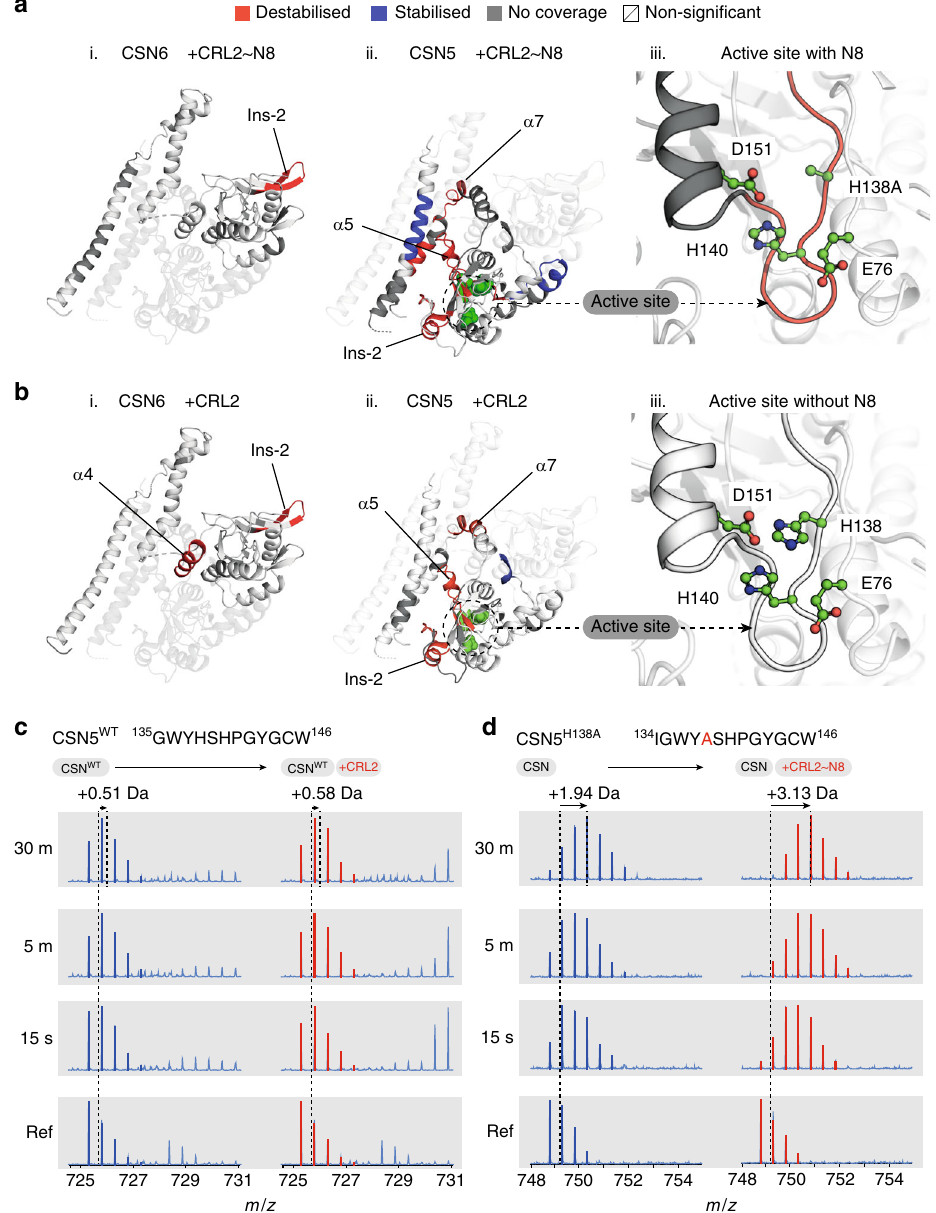
Fig. 4 Conformational response of CSN5/CSN6 to NEDD8. Differential HDX-MS of a Δ (CSN – CRL2~N8 - CSN) and b Δ (CSN WT – CRL2 - CSN WT ). Regions exhibiting signi fi cant deuterium uptake differences in (i) CSN6, (ii) CSN5 and (iii) CSN5 active site are highlighted in red for destabilised and blue for stabilised areas. Regions without coverage or exhibit non-signi fi cant changes are in grey and white, respectively. c – d Deuteration pro fi les of CSN5 active site (as shown in a – b iii). Pro fi les of the c non-neddylated and d neddylated holocomplex (red) are compared with deuteration pro fi les of the isolated CSN (blue). The ion distribution of active site peptide is shown for c and d across reference 0 s, 15 s, 5 m and 30 m timepoints. The mass of the non-deuterated reference peptide is shown by the dotted line. A second dotted line for the holocomplexes (red) indicates the mass of the peptide at the 30 m timepoint. The relative deuterium changes of the active site peptide in c following binding of CRL2 is negligible, while in d , presence of CRL2~N8 leads to a signi fi cant increase in mass. Source Data are provided as a Source Data fi